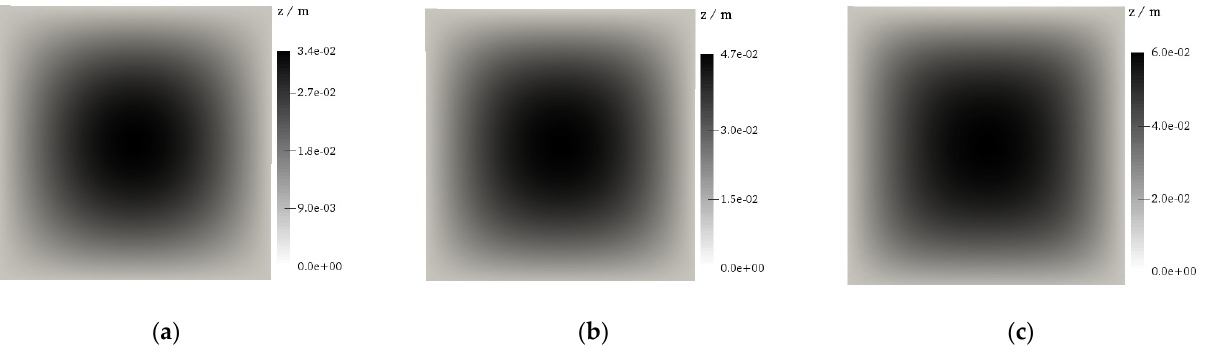
Figure 25. Z coordinates of nodes for strain rate 2.5 × 10 − 3 s − 1 and horizontal shortening of the plate of: ( a ) 1.5 mm; ( b ) 3.2 mm; and ( c ) 5.0 mm.